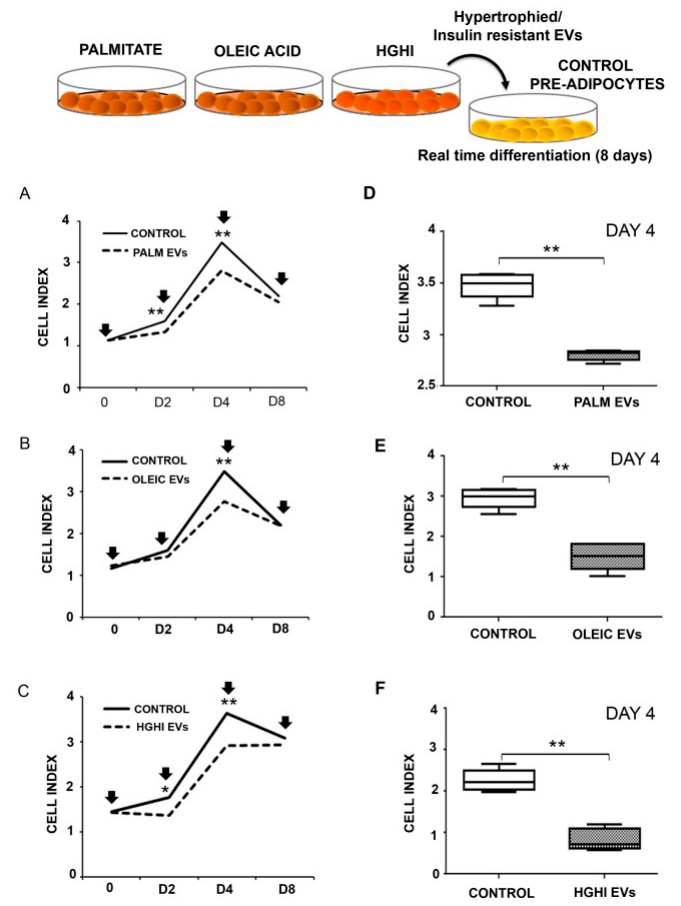
Figure 4. EVs secreted by lipid hypertrophied and insulin resistant adipocytes stimulate neighbored cells atrophy. Real time differentiation of C3H10T1/2 preadipocytes incubated with pathological vesicles ( A : Palmitate EVs; B : Oleic Acid EVs; and C : HGHI EVs) isolated from an equivalent amount of cells (vesicles isolated from the same amount of treated cells) is shown. Cell index graphs are shown from day 0 to 8 of differentiation (3 independent experiments with n = 4 replicates/experiment; vesicles were refreshed every 48 h: days 0, 2, 4, 6, and 8 of differentiation indicated with a black arrow). Box diagrams showing the cell index at day 4 of differentiation for those adipocytes treated with pathological EVs is shown ( D – F ). Comparisons between two groups were performed by Mann-Whitney U test; p ≤ 0.05 was considered statistically significant: * p<0.05 and **p<0.01. .